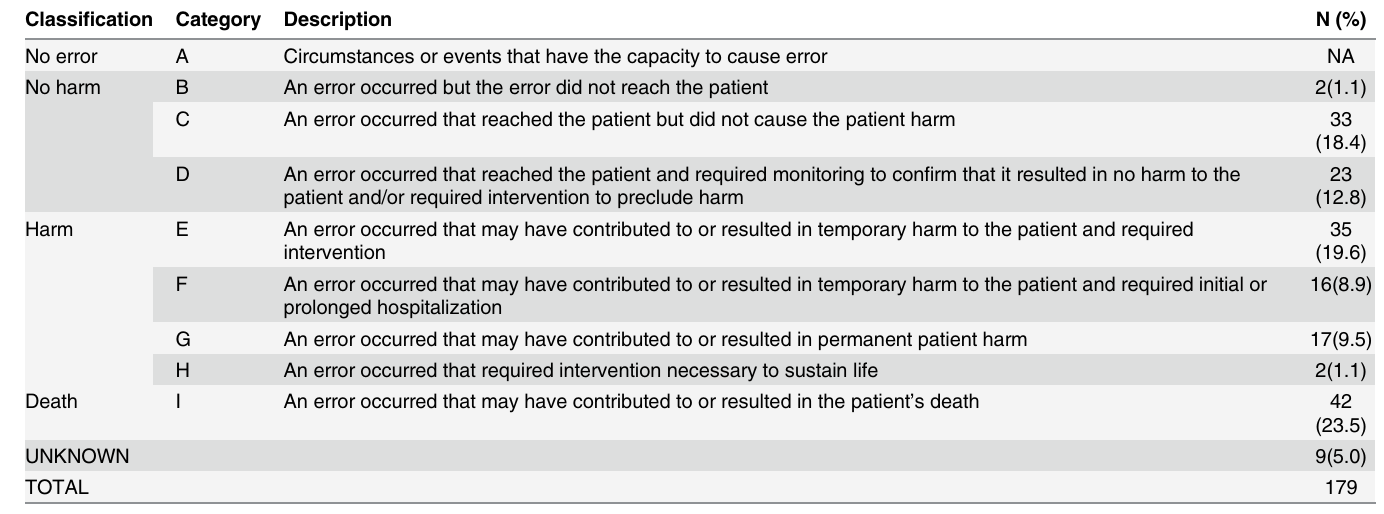
Table 4. Classification of the Impact of Errors. Coding of errors is based on the National Coordinating Council for Medication Error Reporting and Preven- tion classification system. Classi fi cation Category Description N